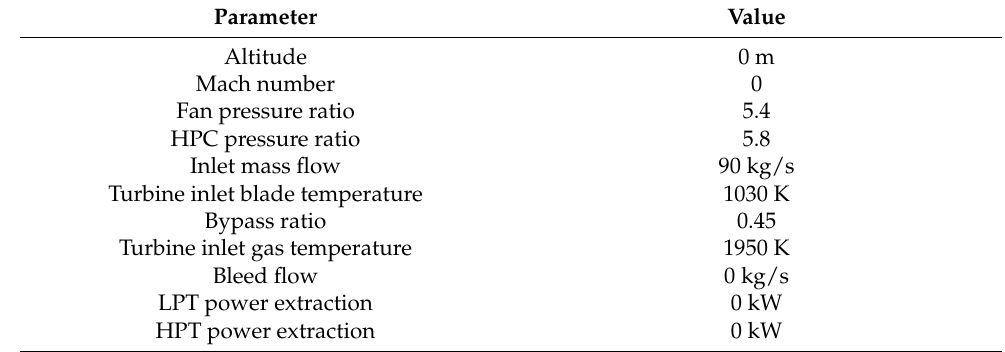
Table 3. Design point